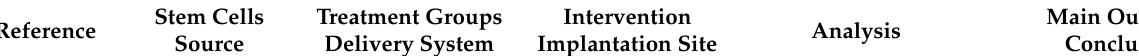
Table 2. Studies selected according to eligibility criteria, in central nerve